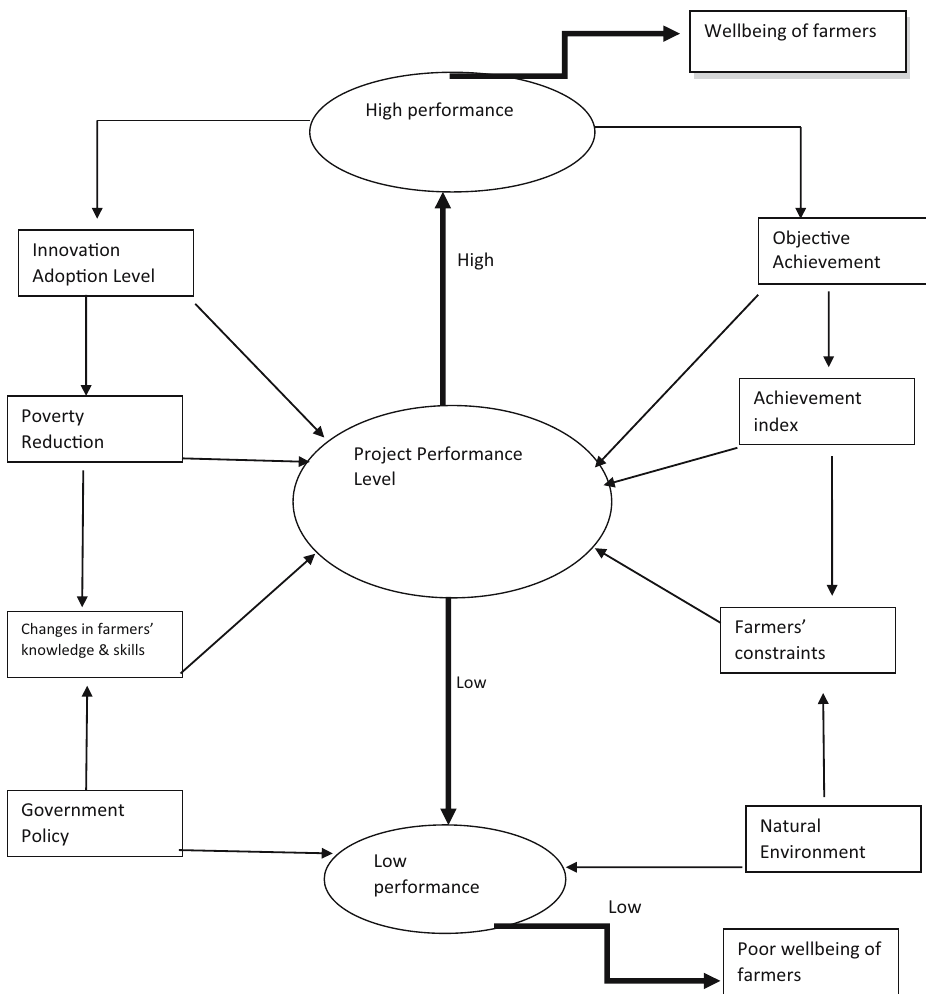
Figure 2: Conceptual framework for evaluating performance of any agricultural